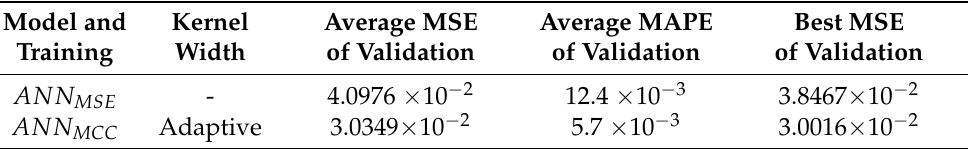
Table 7. Performance comparison of ANN models. State of Charge—training result without the pres- ence of noise or outliers—The Urban Dynamometer